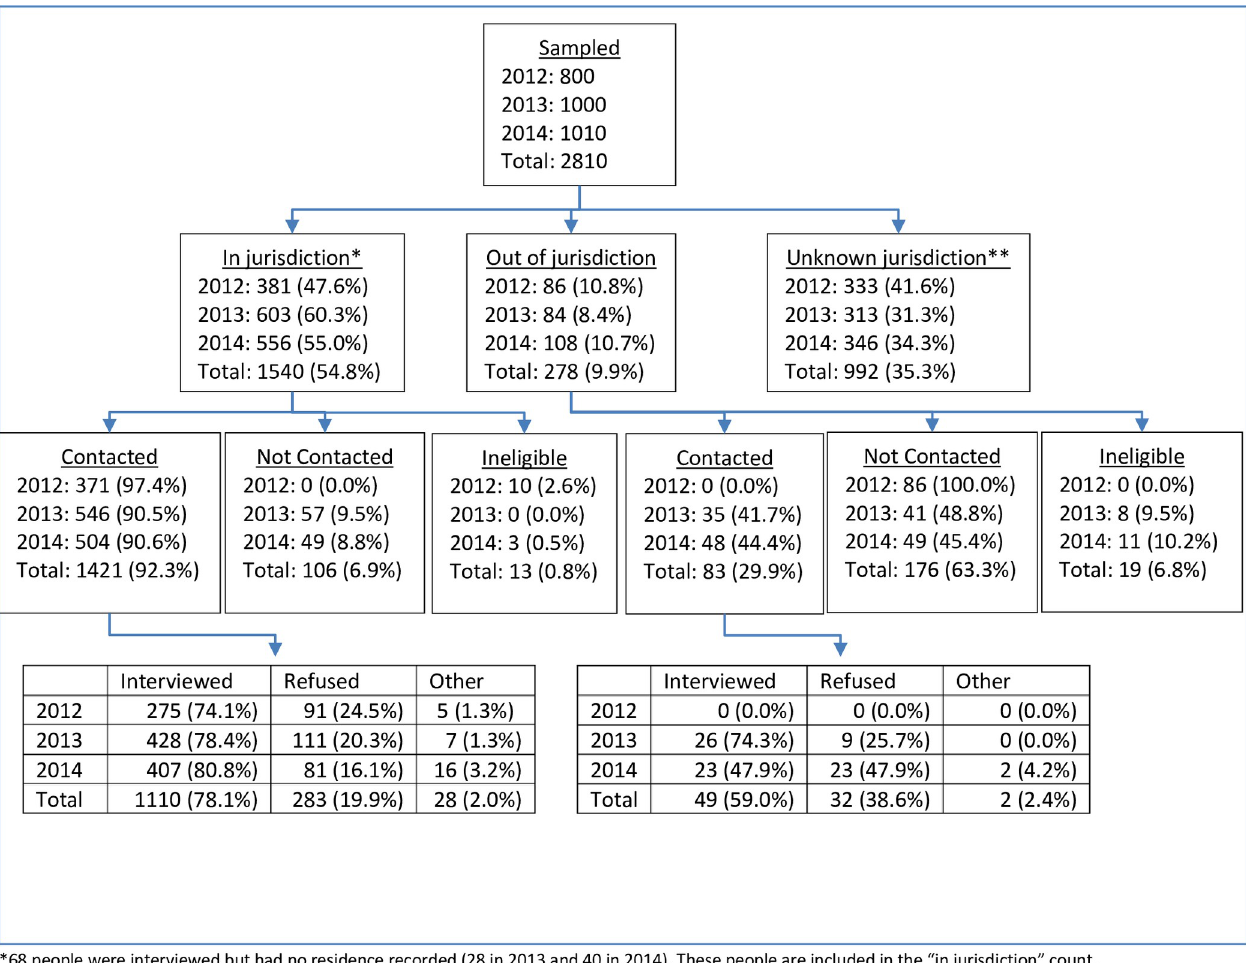
Fig 2. Search and interview recruitment outcomes for sampled persons, Case-Surveillance-Based Sampling demonstration project, 2012–2014.